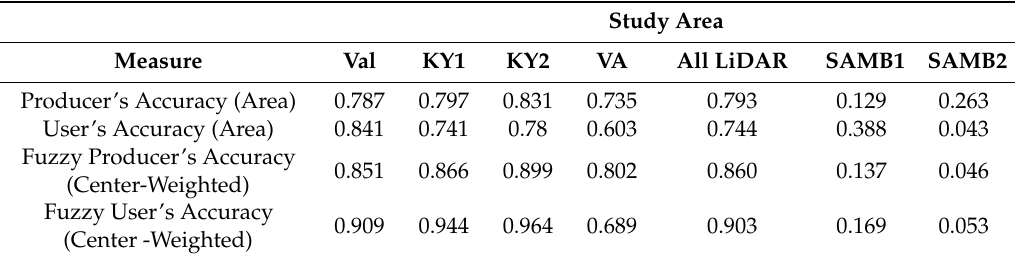
Table 5. Area- and fuzzy area-based error